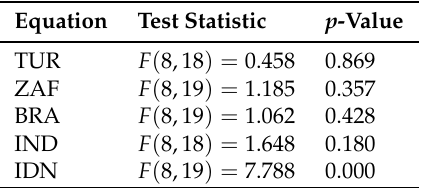
Table 7. The regression equation specification error test (RESET)